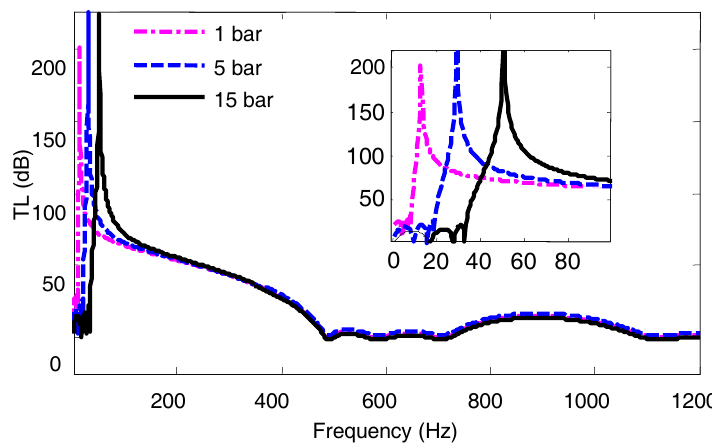
Figure 8. Sound transmission loss of the periodic pipe system under various pressure loadings.